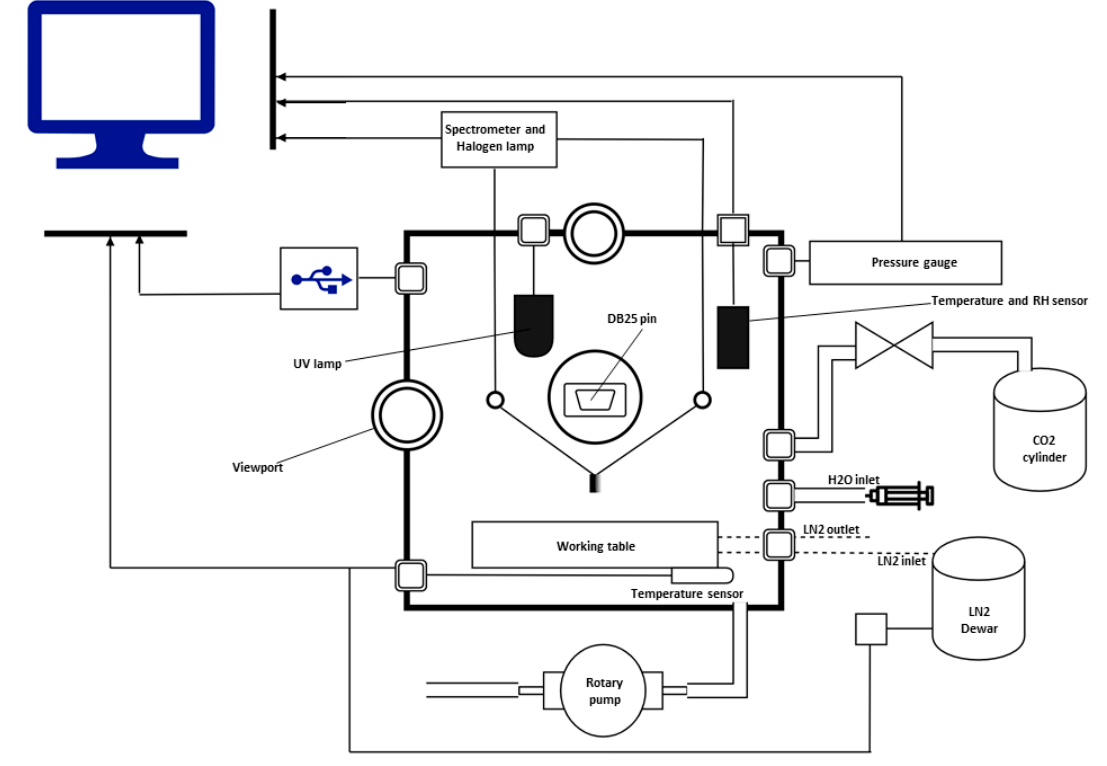
Figure 2. Schematic representation of SpaceQ chamber showing different components fitted.